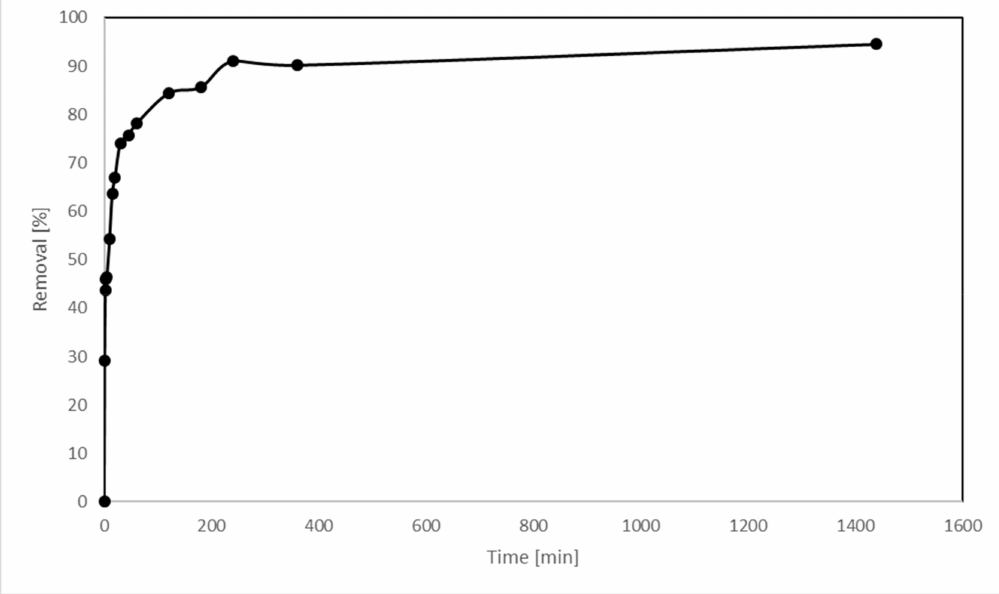
Figure 6. Zinc (Zn) removal [%] as a function of time (minutes). Experiments were done duplicated and the range of results were at maximum 3 percentage